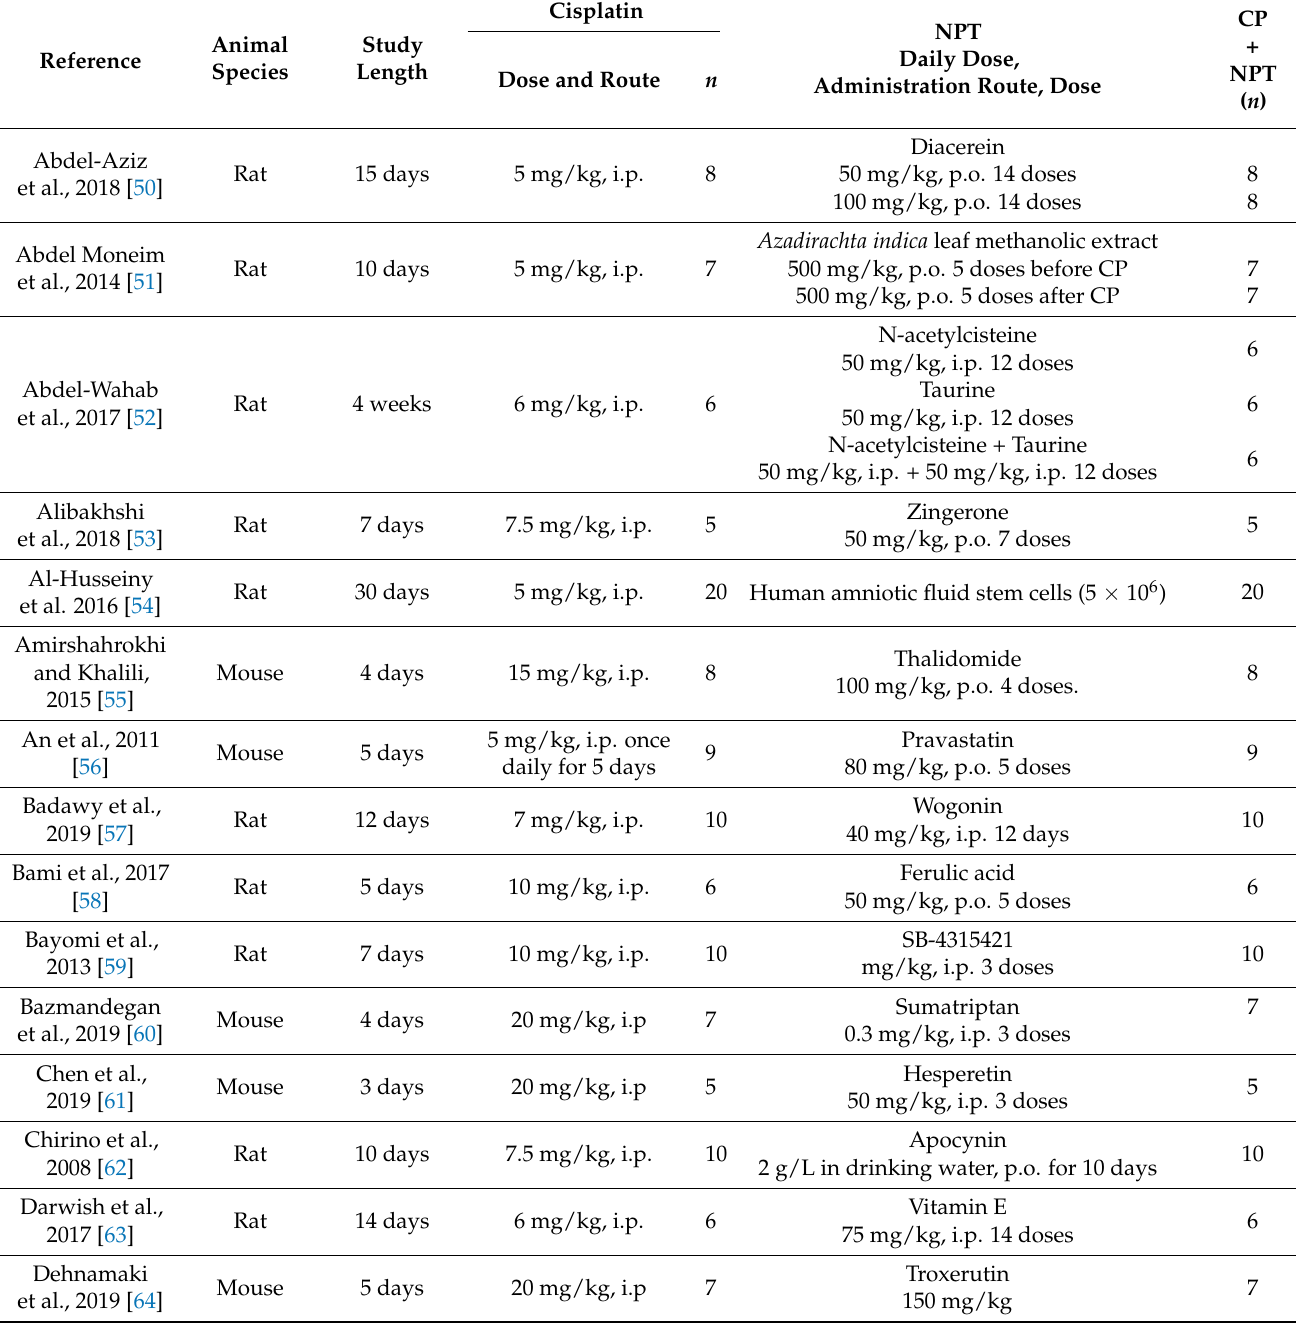
Table 1. Descriptive data of the studies that met the inclusion criteria. CP, cisplatin; i.p., intraperitoneal; i.v., intravenous; NPT, nephroprotectant; p.o., per os (i.e., oral